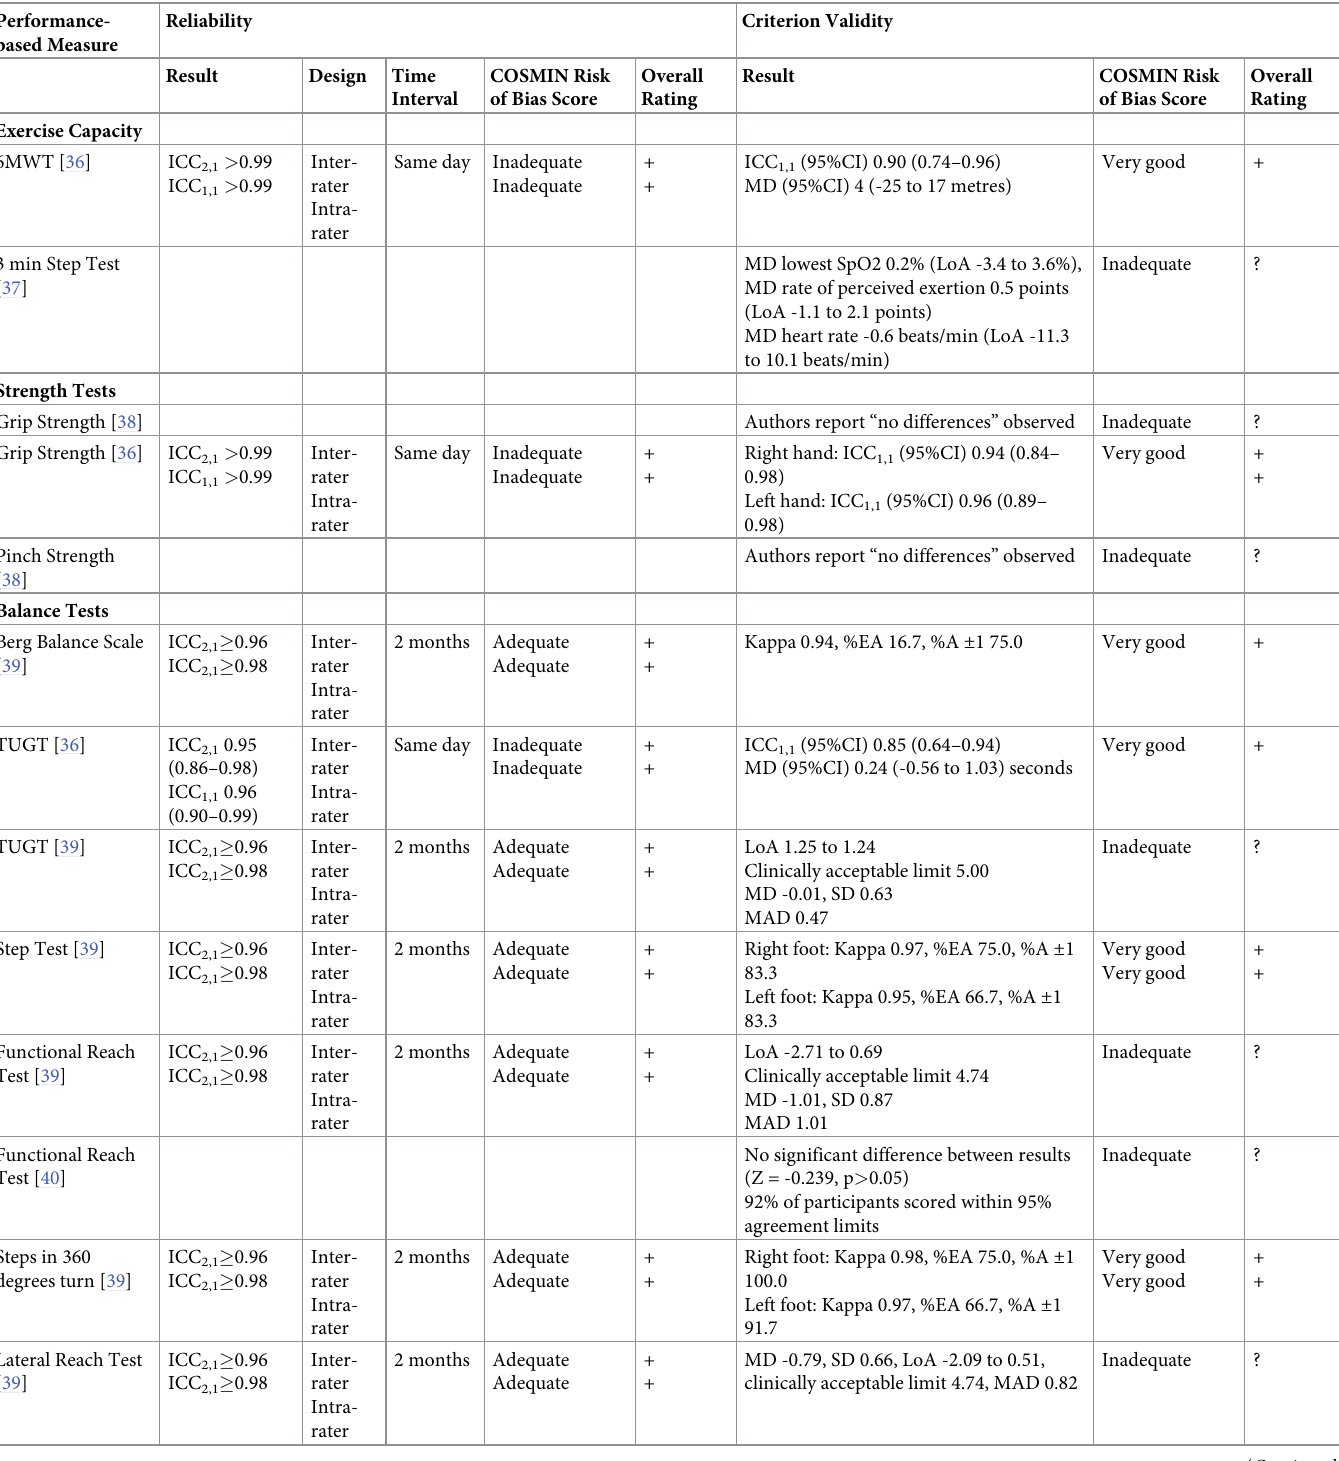
Table 2. Measurement properties of performance-based